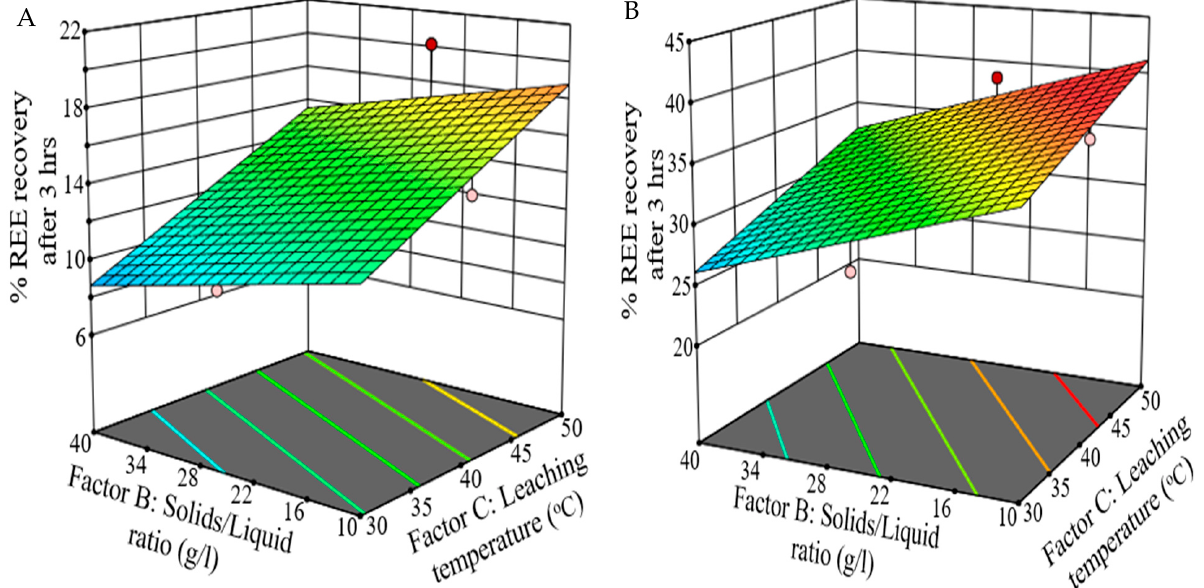
Figure 3. 3D surface plots of the relationship between leaching temperature, pulp density (solid:liquid ratio), and their impact on the % REE leaching recovery for RC1 ( A ) and DC1 ( B ) coals. Figure 4A,B depicts the relationship between the solid:liquid ratio at 10 g/L to 40 g/L and HCl concentration ranging between 0.5 M to 2 M at a constant temperature of 50 ◦ C.